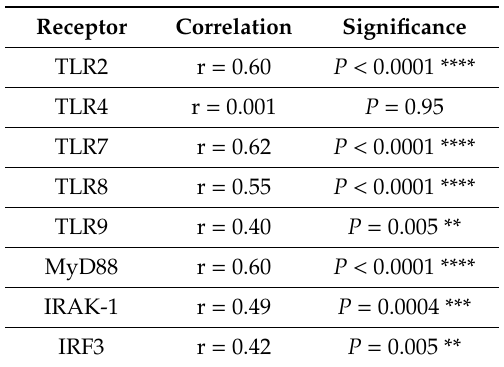
Table 3. Correlation of adipose gene expression of interferon regulatory factor-5 (IRF5) with toll-like receptors (TLRs) and related transcription